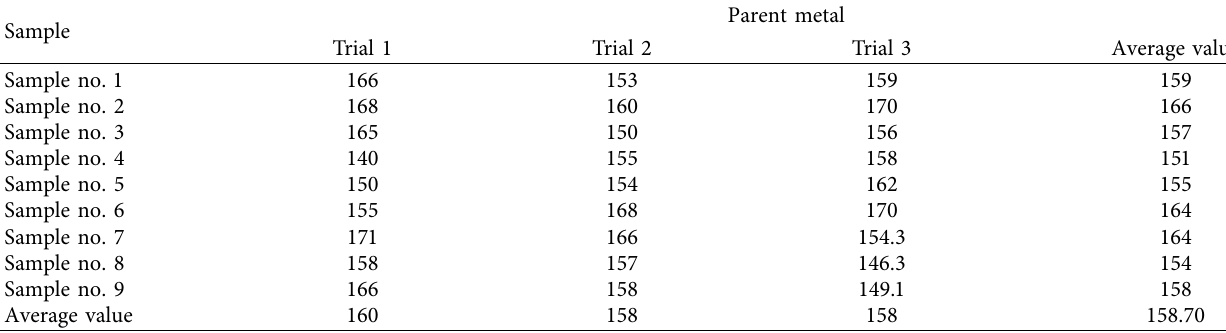
Table 13: Vickers hardness test